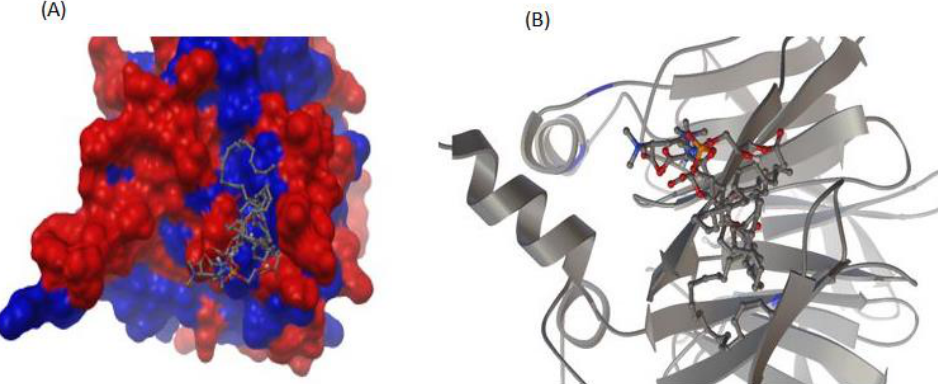
Figure 5. Some of the lipids in the rePON1 groove are orientated nearest α -helix H2. ( A ) The molecular surface of PON1 shows hydrophilic (red) and hydrophobic (blue) zones docked with the lipid. ( B ) Location of the lipid within the rePON1 groove showing interactions with the rePON1 groove using the secondary and tertiary structure of rePON1.